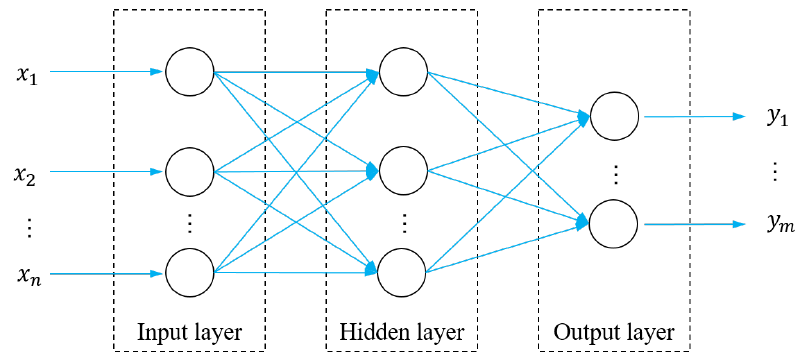
Figure 2. Basic structure of a radial basis functions neural network. For n dimensional input variables